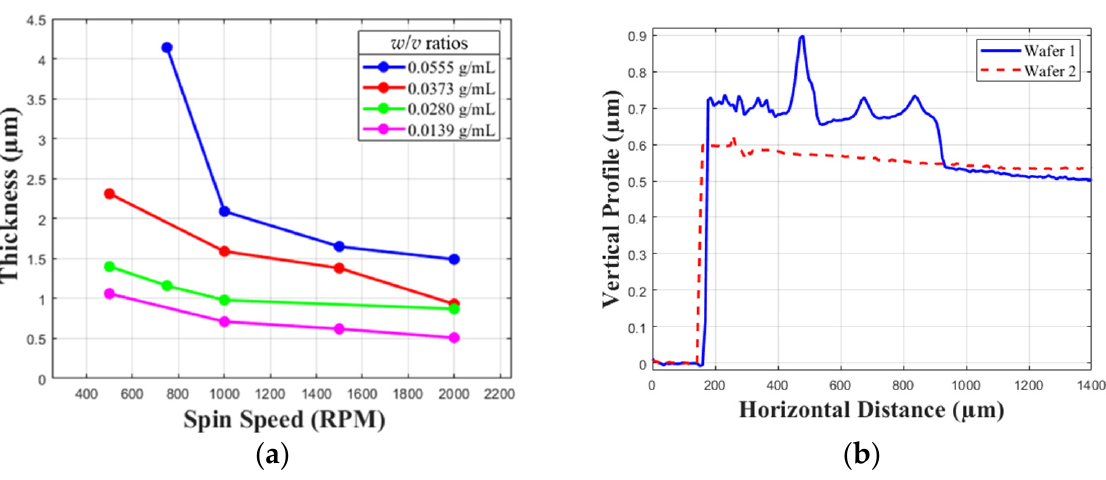
Figure 1. Nitrocellulose membrane and spin-coating data. ( a ) Nitrocellulose spin-coating curves for different solution weight/volume ( w/v ) ratios [36]. ( b ) Nitrocellulose membrane thickness profile for Wafer 1 (6-inch wafer) and Wafer 2 (3-inch wafer).